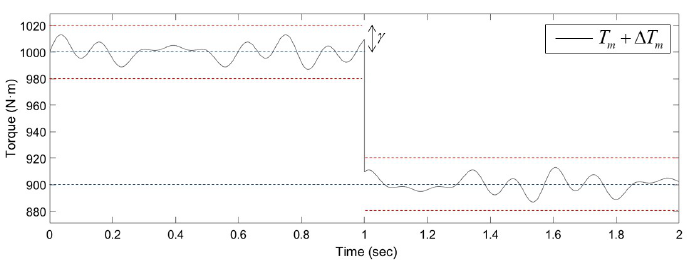
Figure 5. The mechanical torque with external disturbance.